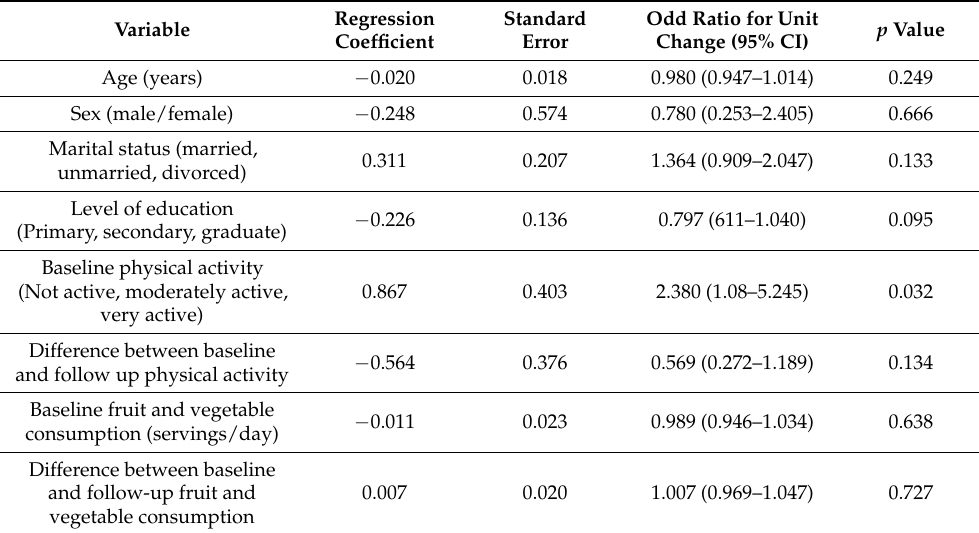
Table 6. Multiple logistic regression analysis of the influence of some clinical prognostic variables on change in body weight (loss vs. gain) of study population at follow-up.